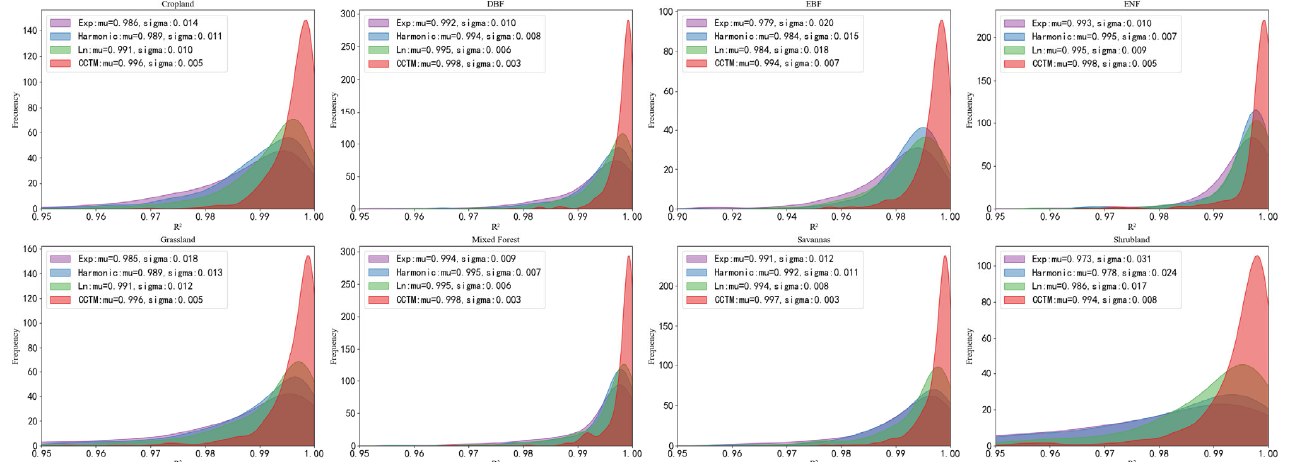
Figure 11. R² probability distribution of reconstructed MSR time series data after smoothing for different landcover types. The frequency is the number of time series points in a certain RMSE range, and different landcover types may have different RMSE categories.